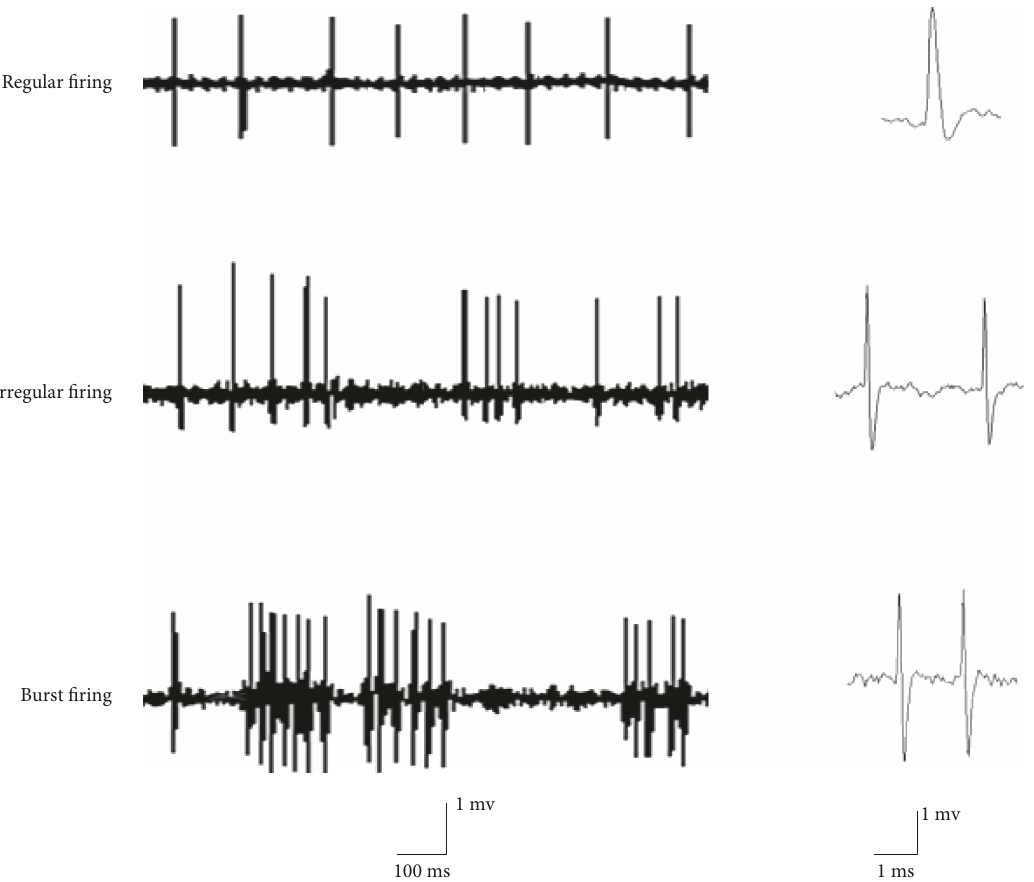
Figure 6: Di ff erent neuronal fi ring patterns in the striatum. Regular fi ring pattern: ISI histogram exhibiting a symmetrical distribution. Irregular fi ring pattern: ISI histogram exhibiting a random distribution. Burst fi ring pattern: ISI histogram exhibiting an obvious positive skewness with a long progressive